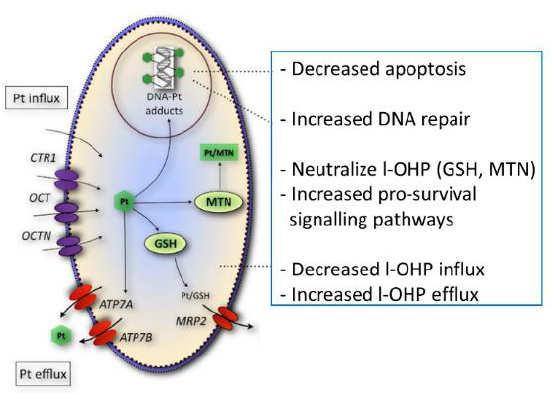
Figure 5. Potential resistance mechanisms for oxaliplatin (l-OHP). Decreased accumulation of l-OHP into the cell is related to a decreased uptake by one of the OCTs or CTR1, while the ATPases, ATP7A, and ATP7B, and MRP2 can efflux platinum (Pt) analogs, including l-OHP. The drug can also be neutralized by glutathione (GSH) or MTN (metallothionein protein). Alternative pathways of resistance may be mediated by a decreased expression of proapoptotic proteins and an increased prosurvival signaling, such as ALDH1 and Akt [16].